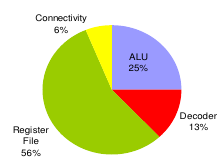
Figure 18. Percentage of total processor power per module for standalone dual issue